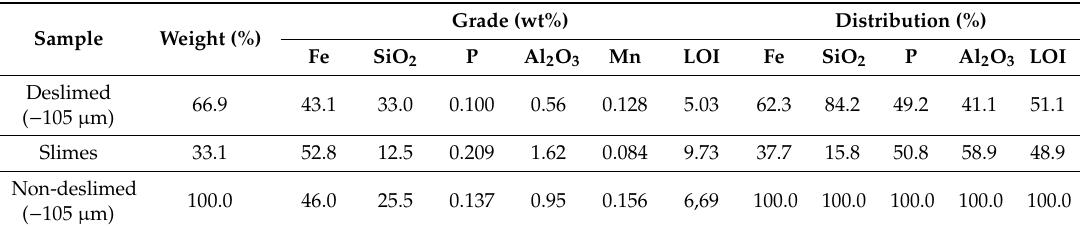
Table 4. Mass and metallurgical balances of the desliming